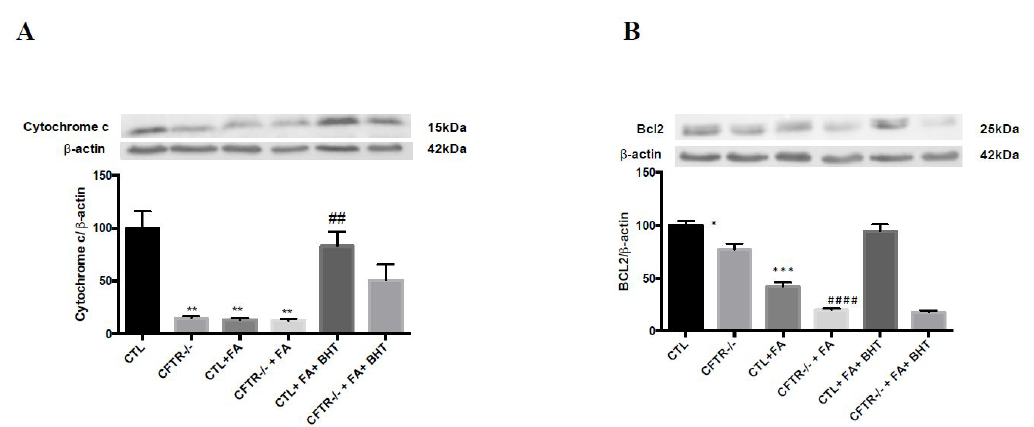
Figure 6. Impact of CFTR depletion on mitochondrial apoptosis-related proteins. Mitochondria were isolated from differentiated Caco-2/15 cells by ultracentrifugation. Then, protein mass of ( A ) cytochrome c and ( B ) B-cell lymphoma 2 (Bcl2) was quantified by western blotting. Values are means ± SEM of 3 independent experiments, each performed in triplicate. * p < 0.05, ** p < 0.01, *** p < 0.001 vs. CTL cells; ## p < 0.01, #### p < 0.0001 vs. CFTR -/- cells. CTR: control cells; FA: iron/ascorbate (200 µ M/0.5 mM); BHT: Butylated hydroxy toluene (0.5